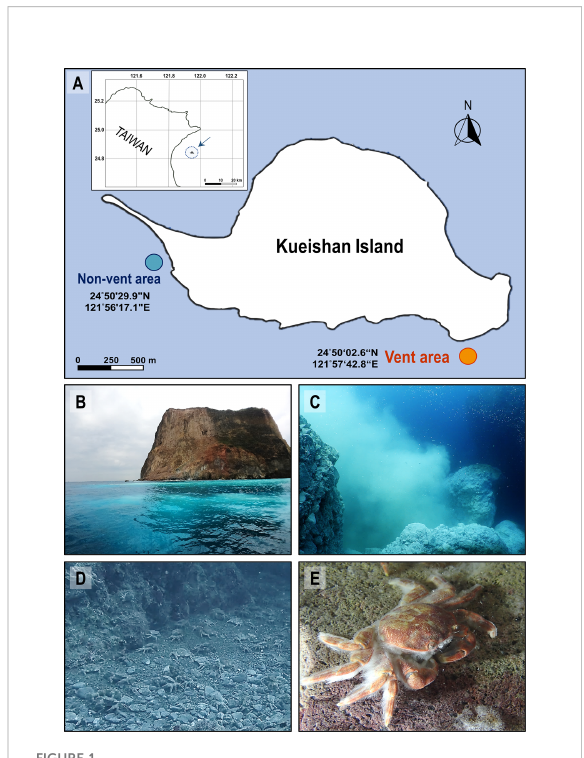
FIGURE 1 Landscape of the shallow-water hydrothermal vent system off Kueishan Island and representative images of hydrothermal vent crabs. Map shows Kueishan Island, which is located off the northeastern coast of Taiwan ( A , upper left). Relative positions, latitude and longitude coordinates of the sample collection sites (vent and non-vent areas) (A) . The photos show the southeastern tip of Kueishan Island, where white sulfur plumes are visible on the sea surface (B) , which is emanated from the subsurface hydrothermal vent system (C) . A large number of endemic crabs ( Xenograpsus testudinatus ) inhabit the vent area (D) . A white bio fi lm can be observed on the carapace surface of the animals (E)